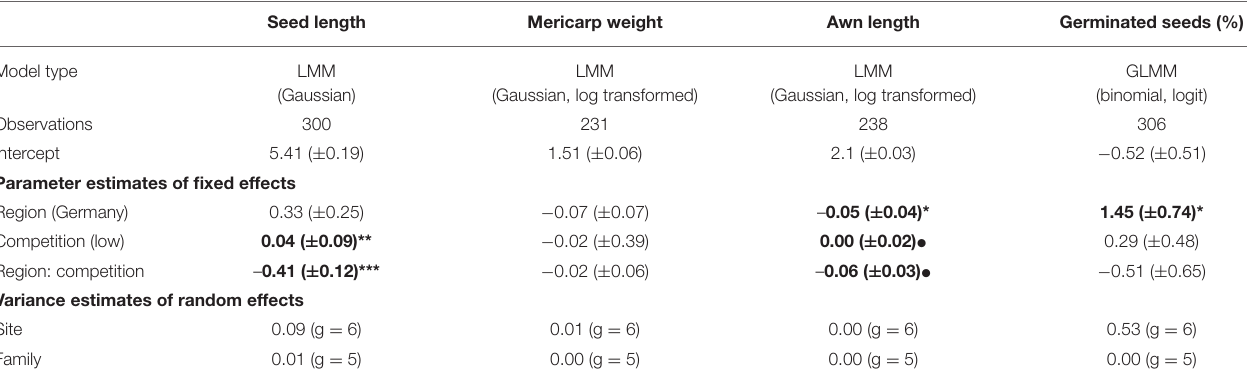
TABLE 1 | Statistical analyses of the effects of geographic region of seed origin and level of ancestral competition on reproductive traits and proportion of germinated seeds of Erodium cicutarium plants (1st laboratory